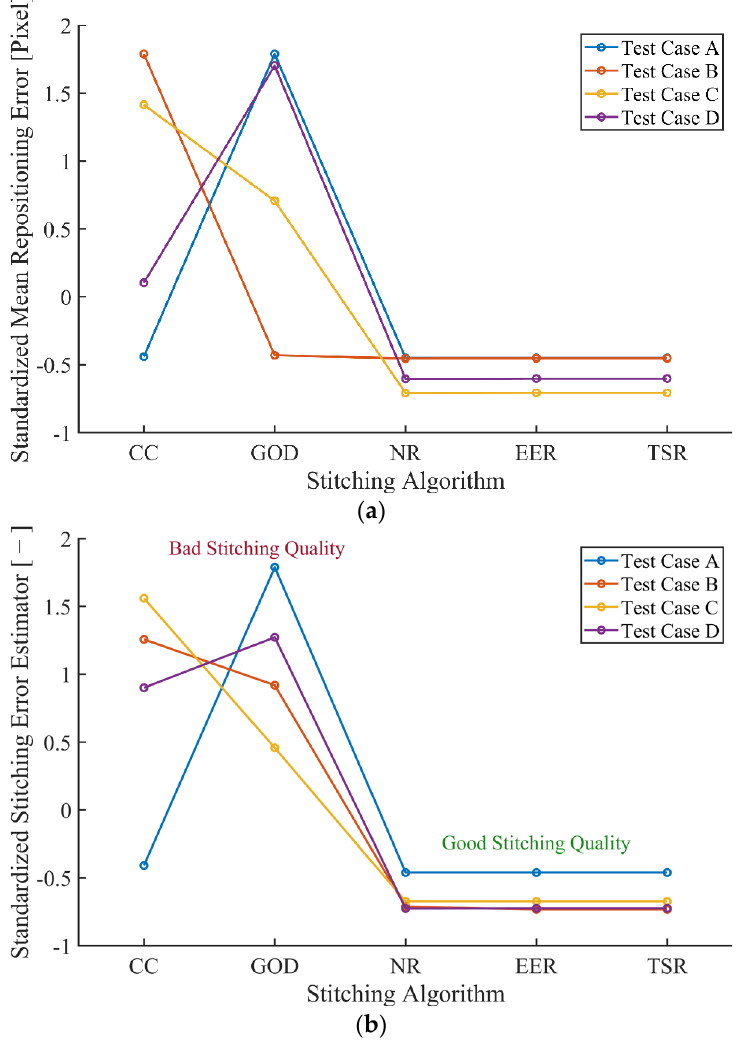
Figure 16. Standardized mean repositioning error ( a ) and stitching error estimator ( b ) for each test case.